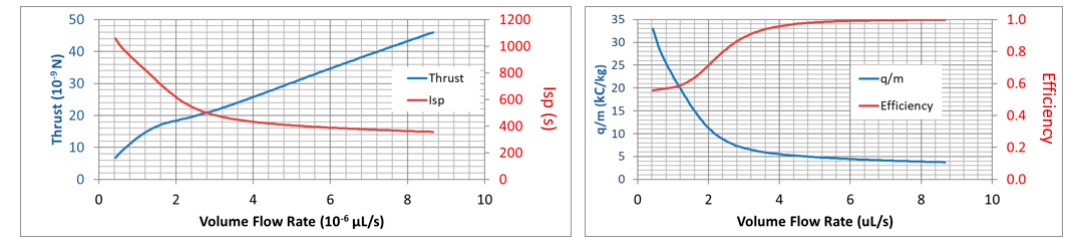
Figure 9. ESPET performance outputs for system shown in Figure 7.